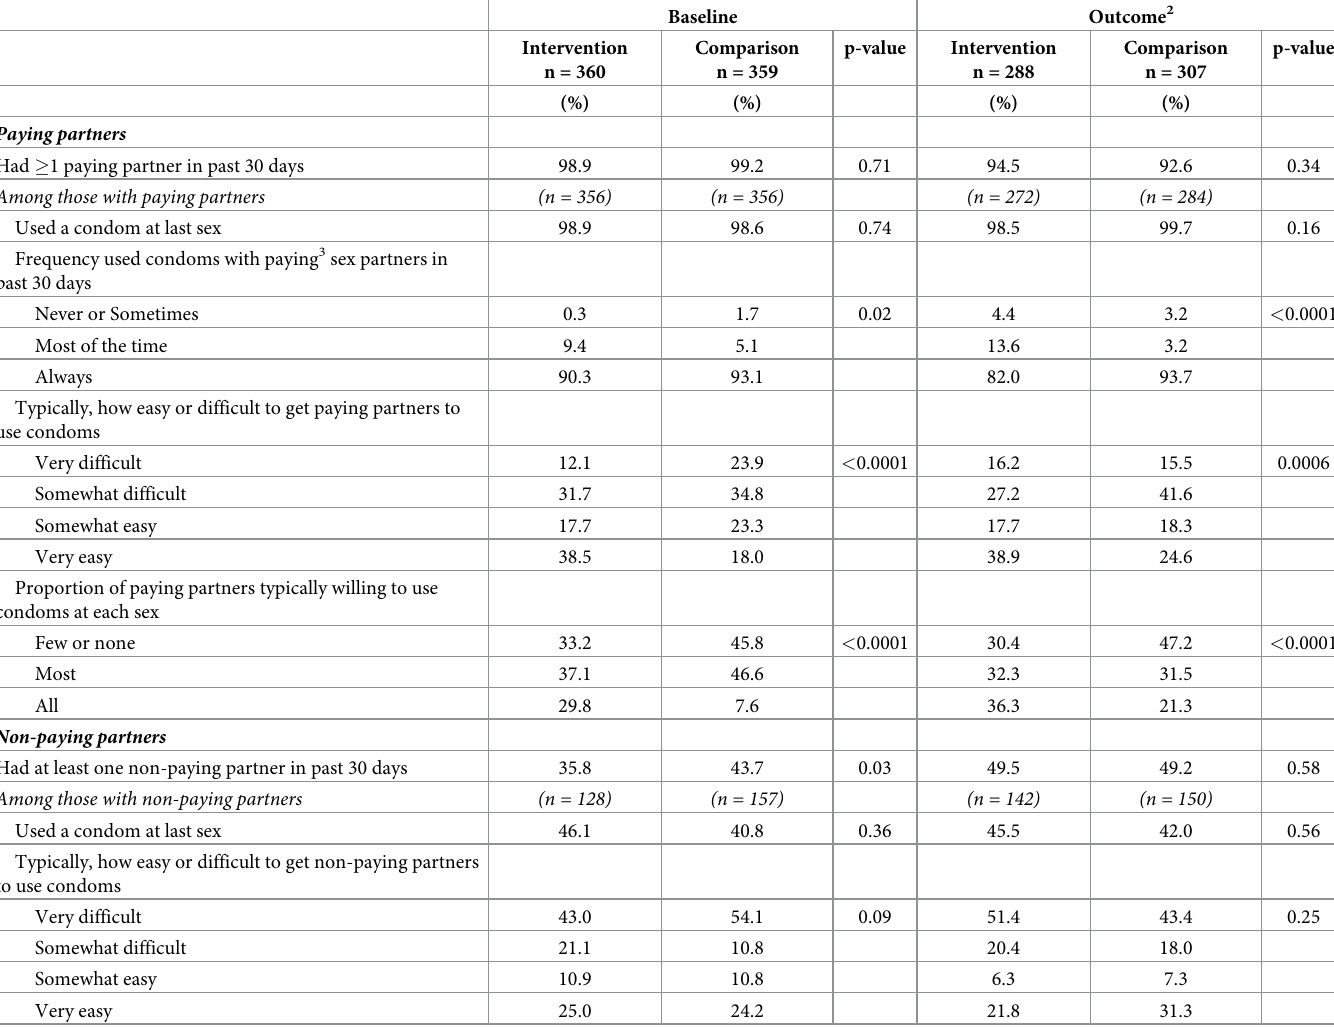
Table 4. Condom use characteristics by partner type among respondents who reported having each partner type, baseline and outcome data (non-imputed data).